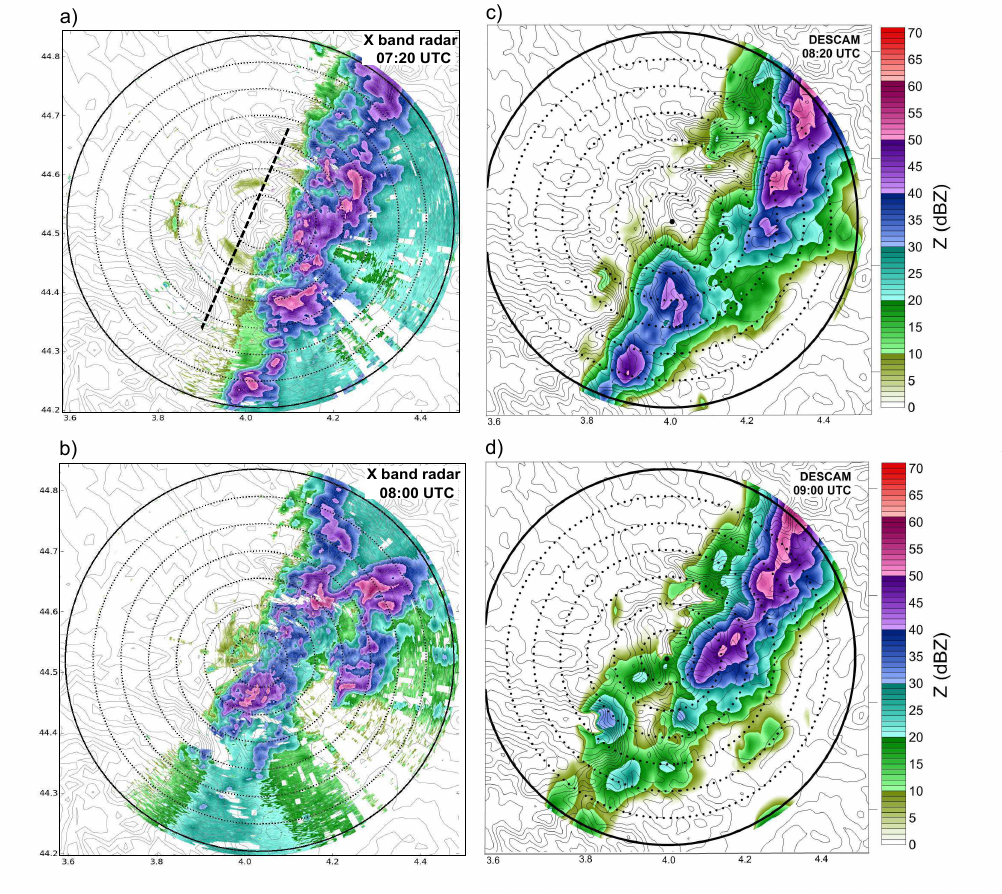
Figure 2. Radar reflectivity observed with the LaMP X-band radar ( a , b ) and simulated with DESCAM ( c , d ) at different time steps of the mature stage of the cloud system (i.e., at 07:20 UTC ( a , c ) and at 08:00 UTC ( b , d )), considering the 1 h delay (see details in Section 3.2). The representation of these figures is the Plan Position Indicator (PPI) Radar Image. The model results outside the observational area are not represented. The dashed line indicates the mountain